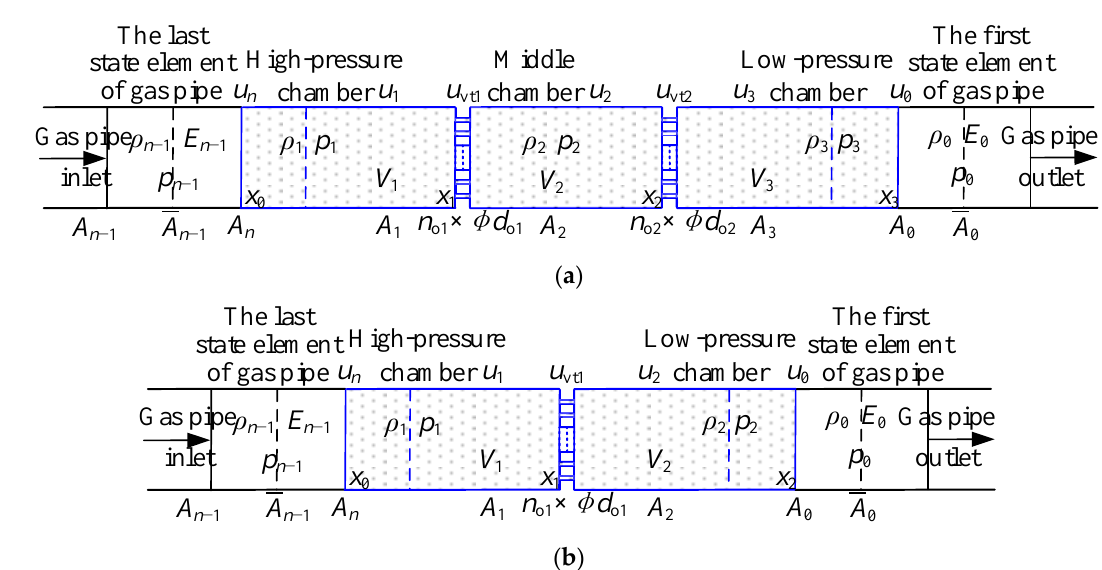
Figure 4. Finite control volume grids of gas steady apparatus. ( a ) Three-chambers and two-orifices structure. ( b ) Two- chambers and one-orifice structure.